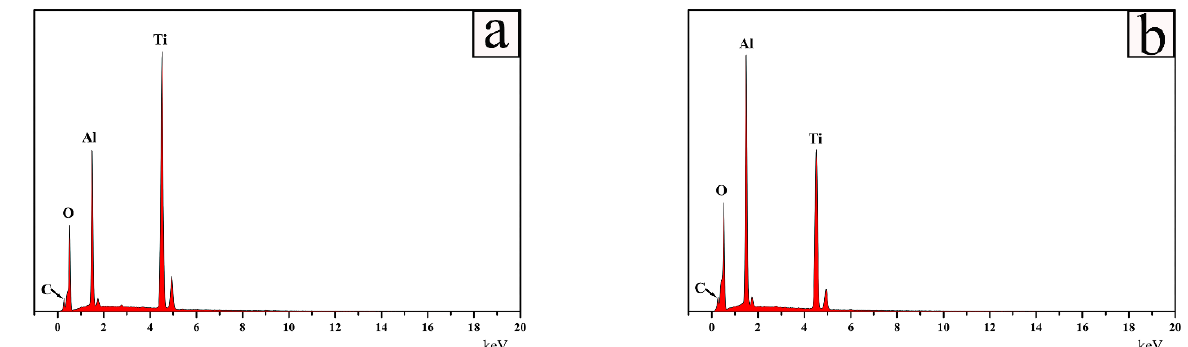
Figure 5. XRD patterns of Ti 2 AlC samples quenched in water at different temperatures: ( a ) 25 °C,